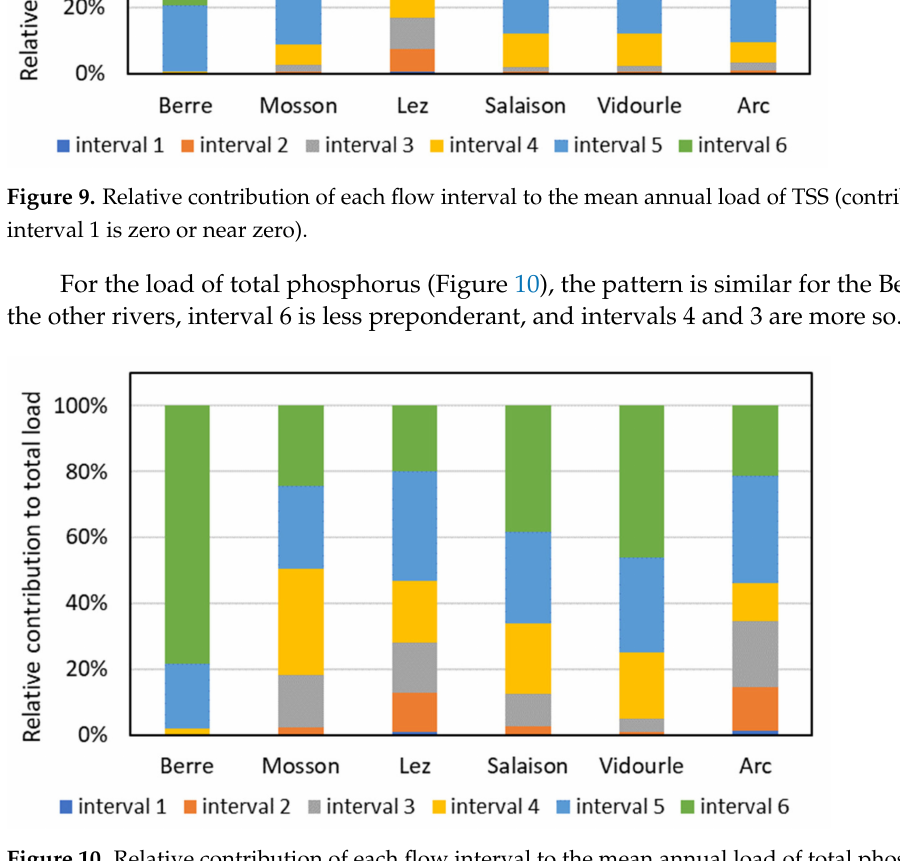
Figure 10. Relative contribution of each flow interval to the mean annual load of total